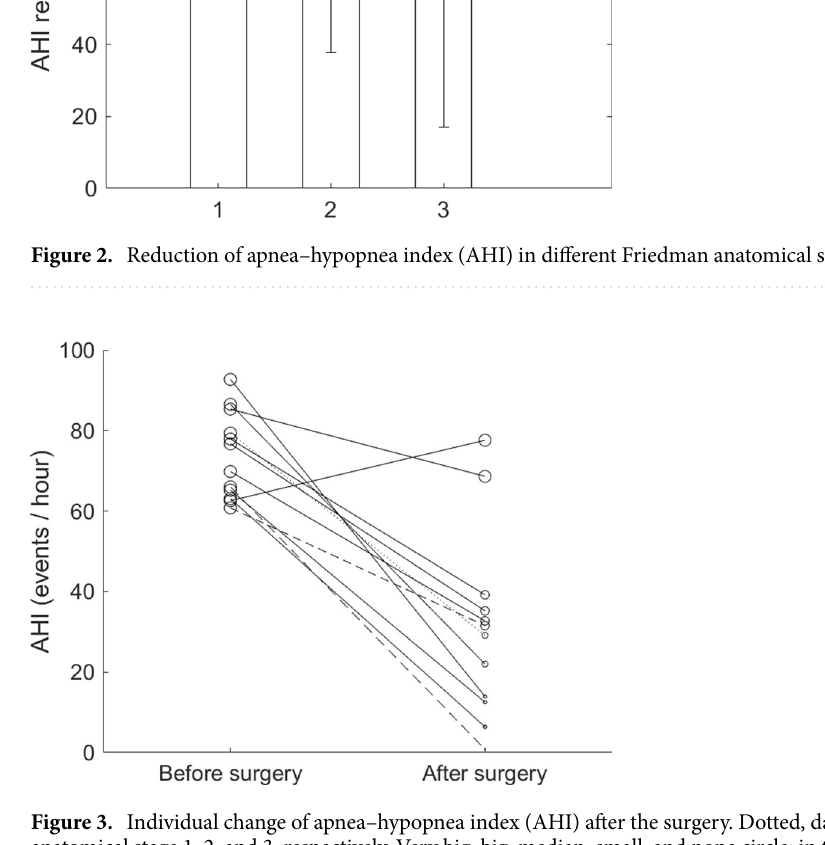
severe OSA with residual on-CPAP AHIs, or have a low level of daytime PaO2 but refuse the proposed direct skeletal surgery 13 , bariatric surgery 23 , or tracheostomy 24 , or refuse use of CPAP device. A majority (83%) of the patients improved from the very severe category to milder ones and might reduce its comorbidity (e.g., 30–35 ). The rest (17% or 2 out of 12 patients) remained in the very severe group. The AHI made worse from 62.6 to 77.6 events/h after the surgery in case 7 and a little lessened from 85.4 to 68.6 events/h in case 6 (Table 1). To further understand the change made by the surgery in these 2 patients, we looked into matters of the PSGs before and after the surgery. In case 7 (the subject with worsened AHI after the surgery), the apnea part (i.e., OAI), improved from 38.6 to 31.9 events/h, and his minimum SpO2 improved from 50 to 84%. In case 6, the OAI reduced from 73 to 1.3 events/h, and his minimum SpO2 increased from 56 to 71%. Minimum oxygen (O2) saturation has been listed as one of the main sleep-disordered breathing parameters besides AHI (e.g., see 17,29,37,39 ) or used as one criterion to classify the severity of OSA (e.g., see 40–42 ). So, we analyzed individual changes of minimum SpO2 in addition to OAI (Fig. 4). The mean OAI reduced from 44.03 to 5.79 events/h with a reduction rate of 86.8%, which showed that the OAI reduction (86.8%) was better than AHI reduction (58.3%). These results showed that the surgery reduced more portion of obstructive apnea than hypopnea. The sum of apneas and hypopneas per hour did not cut as many as the sum of apneas per hour—some